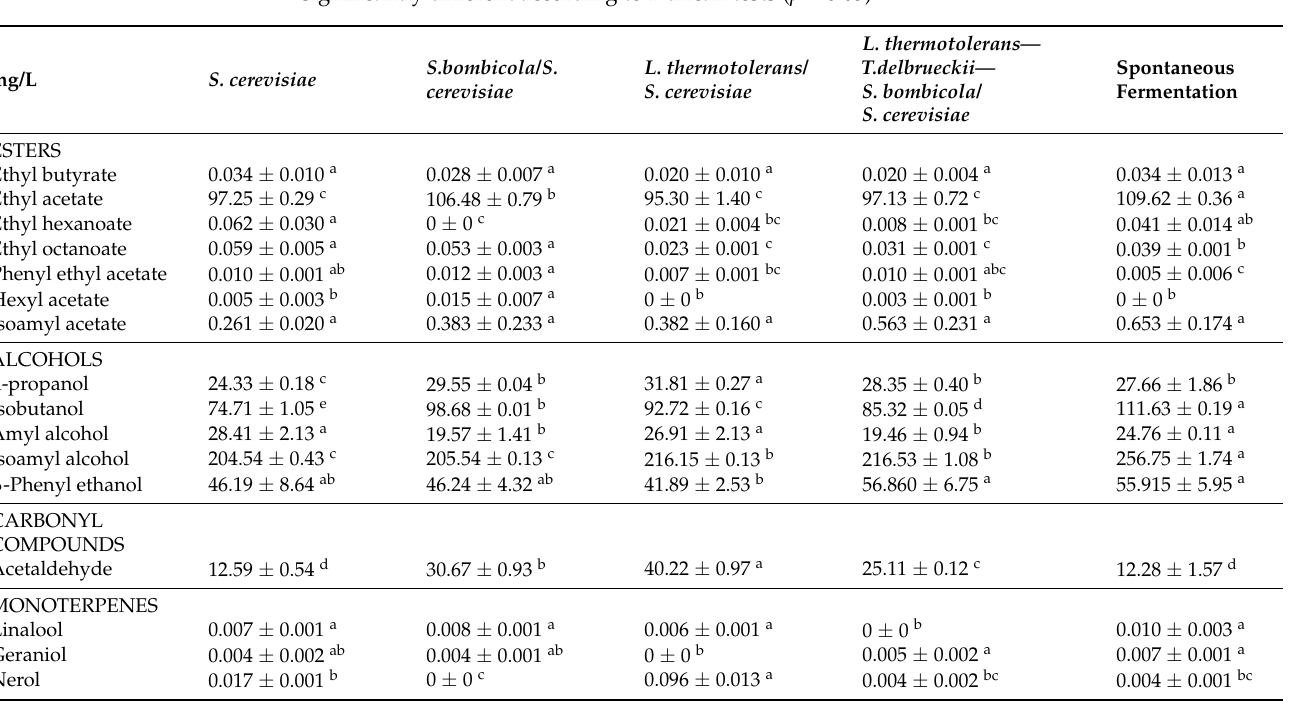
Table 3. The main by-products of fermentation and volatile compounds of the wines. Data are means ± standard deviations. Values displaying different superscript letters ( a–e ) within each line are significantly different according to Duncan tests ( p <